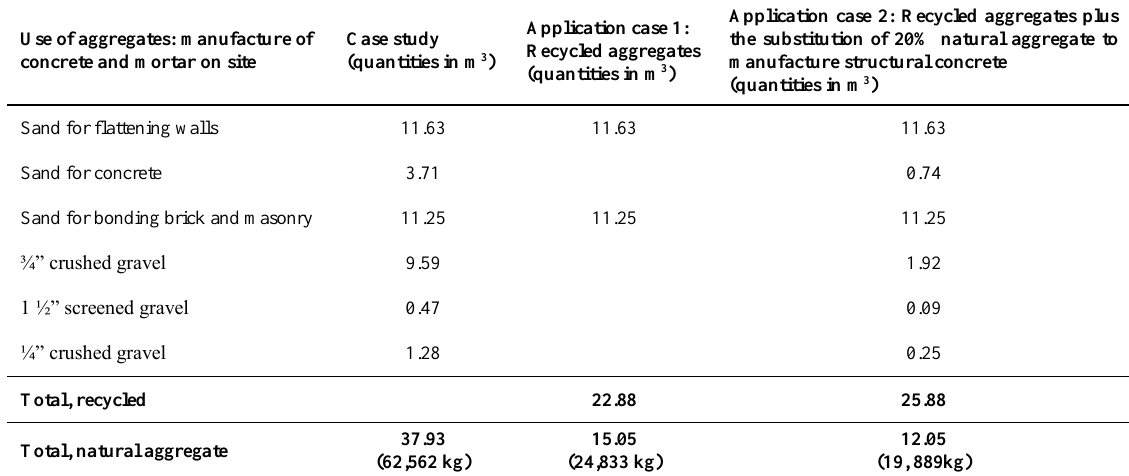
Table 4. Proposed amounts for aggregate recycling at the construction